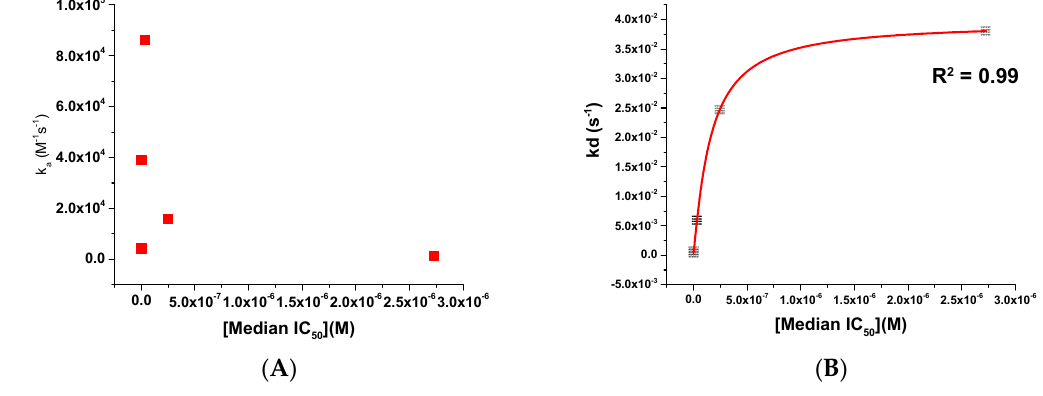
Figure 3. Scatter plots showing ( A ) k a versus median IC 50 and ( B ) k d versus median IC 50 for compounds BMS-626529, SC11, SC16, SC18, and SC39. The red line in panel ( B ) shows a logarithmic trend line fit to the data.